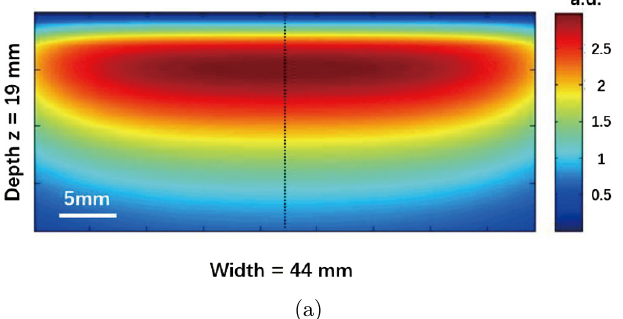
Fig. 6. (a) Relative (cid:2) map of the central cut plane. (b) Relative °uence along the dark dotted